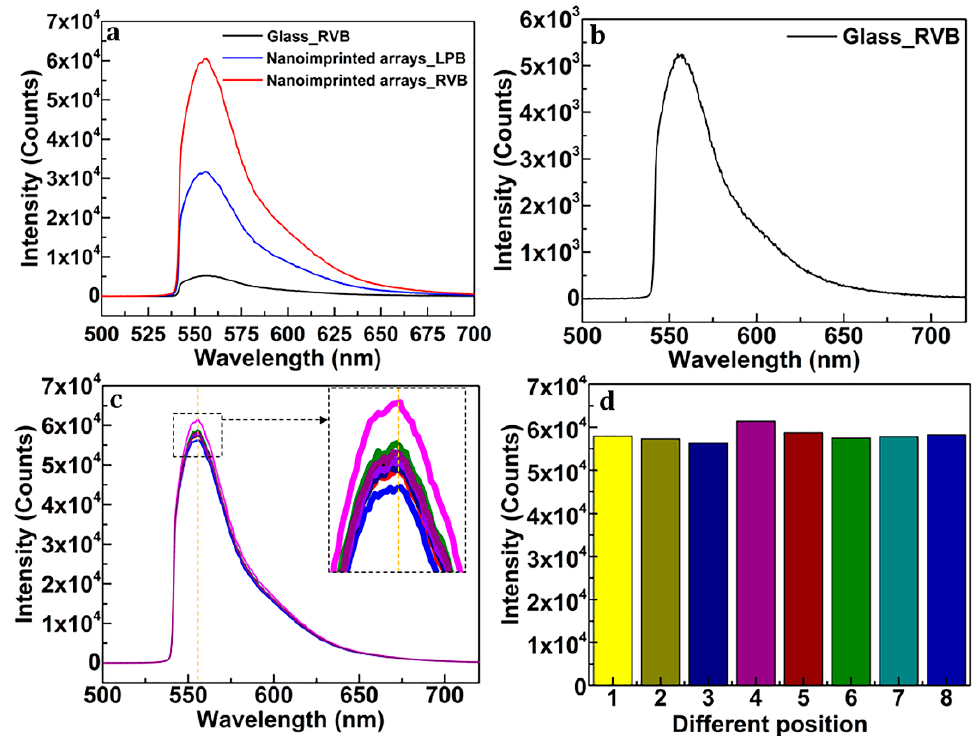
Figure 4. ( a ) The fl uorescence spectrum of R6G (dispersed in alcohol) on the sur-face of the nanoim- printed substrate excited via RVB (red) and LPB (blue), respectively, and that on the surface of com- mon glass (black) excited via RVB. The integration time is 1 ms. The R6G dispersion has concentra- tion of 10 − 4 M. ( b ) The enlarged line of the spectrum (black) shown in ( a ). ( c ) The fl uorescence spec- trum of R6G dispersion enhanced by eight positions of the nanoimprinted substrate. The right